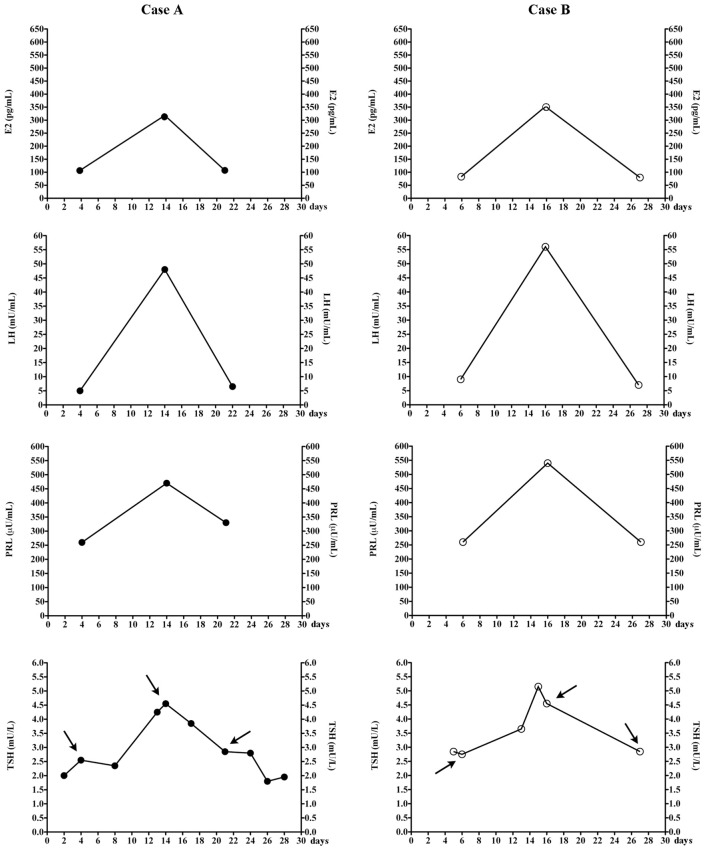
Changes of estradiol (E2), luteinizing hormone (LH), prolactin (PRL), and thyrotropin (TSH) in the two women, during the menstrual cycle. Arrows indicate TSH levels that were measured at the same time when the other hormones were also measured. The total number of menstrual cycles during which TSH levels were measured are nine for patients A and five for patients B. In our laboratory, follicular, midcycle, and luteal phase serum E2 ranges 23–139, 83–495, and 42–338 pg/mL (chemiluminescent assay by Beckman Coulter).